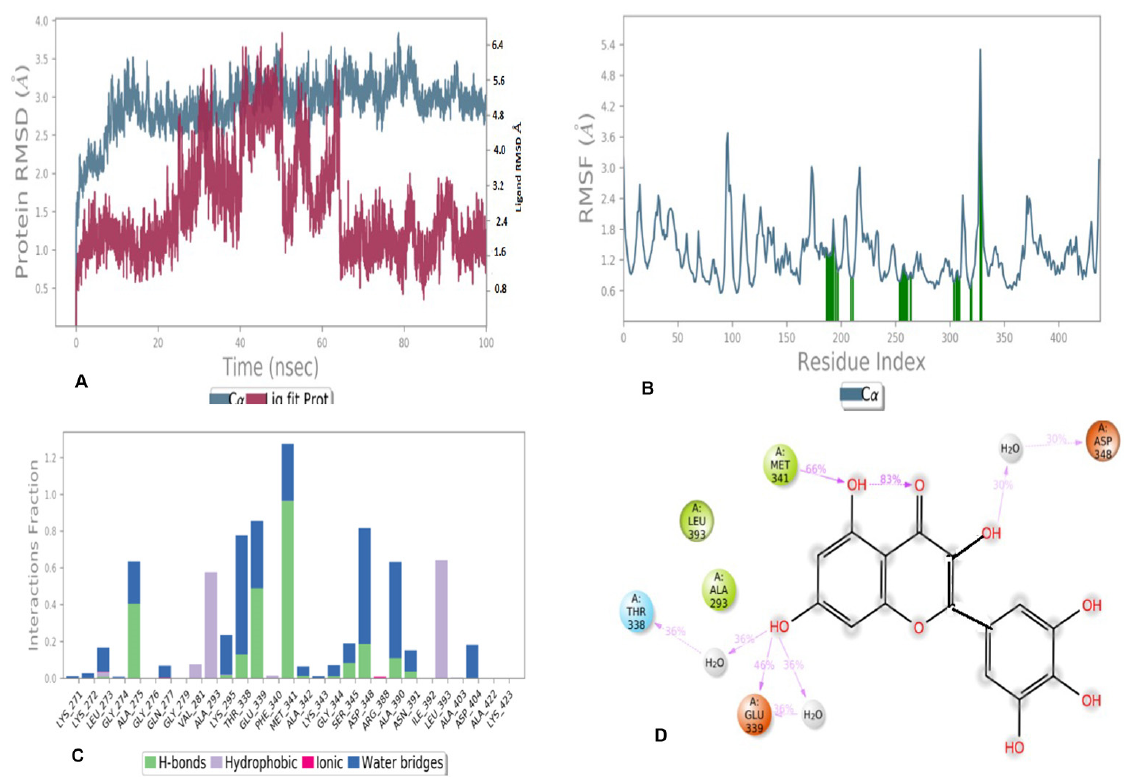
Figure 11. MD simulation results of compound 6 with receptor 2HCK: ( A ) Time-dependent protein- ligand root mean square deviation (RMSD) plots, ( B ) Root mean square fluctuation (RMSF) plots, ( C ) Simulation interactions with bar diagram indicating the fold of interaction, fraction, and contacts, and ( D ) 2D binding interactions.